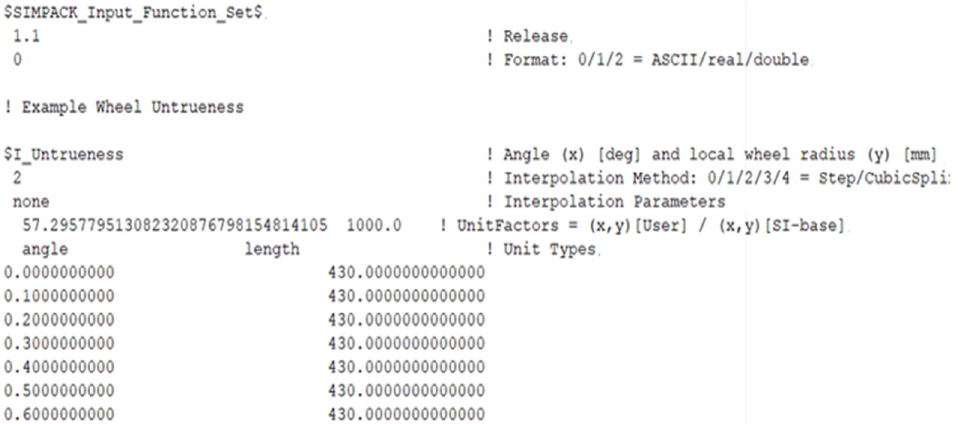
Figure 5. Coordinate values using Acro Edit.